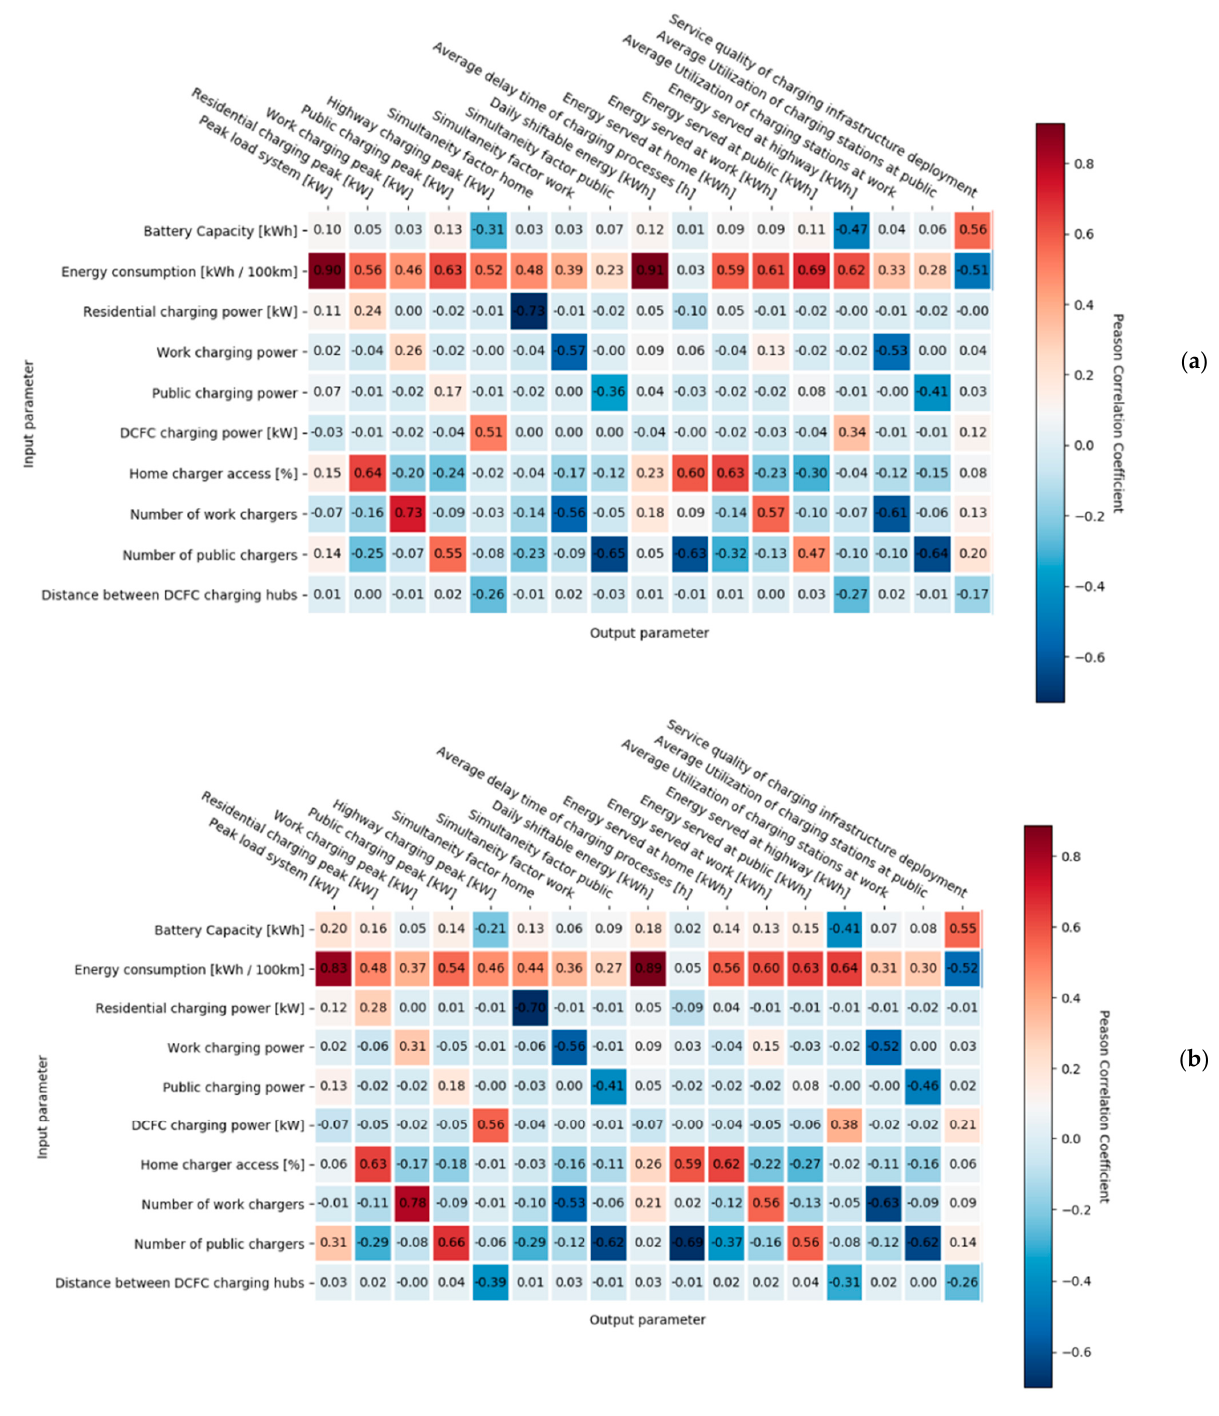
Figure A2. Pearson Correlation Coefficient Matrix for ( a ) rural and ( b ) urban.